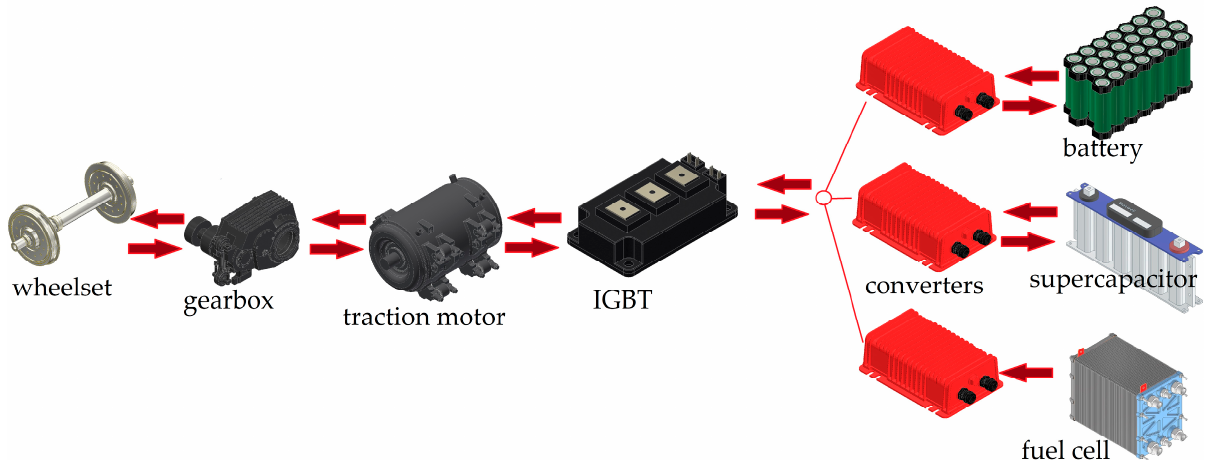
Figure 1. Power flow according to traction system topology.